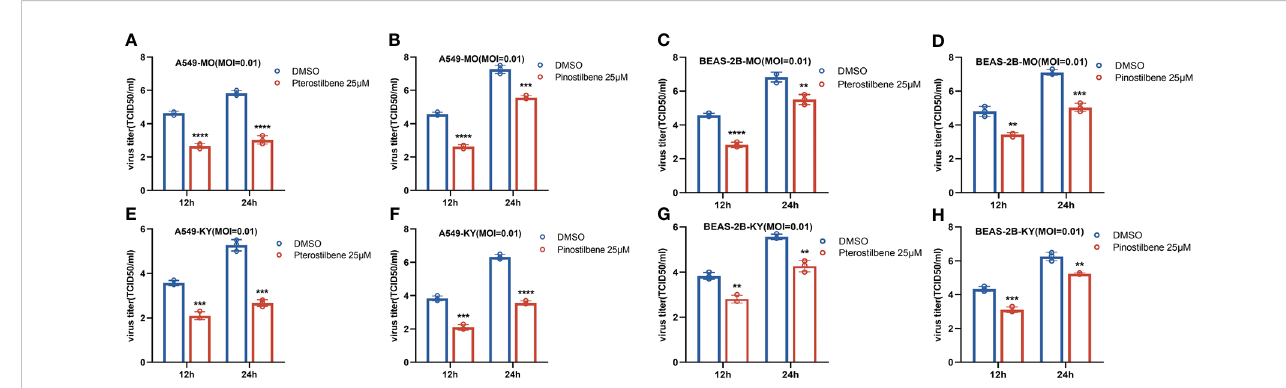
FIGURE 6 Pterostilbene (Pte) and pinostilbene (Pin) inhibit isolated circulating strains of EV-D68. (A – H) A549 or BEAS-2B cells were pre-treated with 25 m M Pte, or 25 m M Pin, or DMSO vehicle and then infected with US/MO/14-18947 (MO) or US/KY/14-18953 (KY). Cells were incubated under standard conditions. The titers of progeny virions were determined 12 or 24 h post-infection. The experiment was performed thrice. Error bars indicate the standard deviation (**, P < 0.01; ***, P < 0.001; ****, P < 0.0001). EV-D68, Enterovirus D68; DMSO, dimethyl sulfoxide; MO and KY, isolated EV-D68 circulating